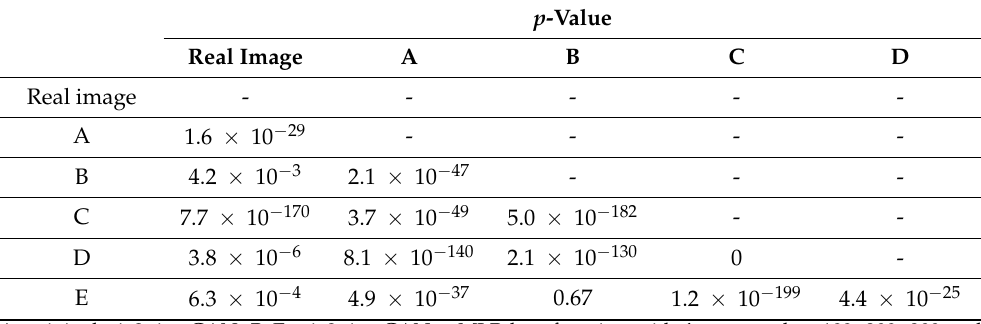
Table 6. McNemar’s test computed in paired results of all semantic segmentations performed.